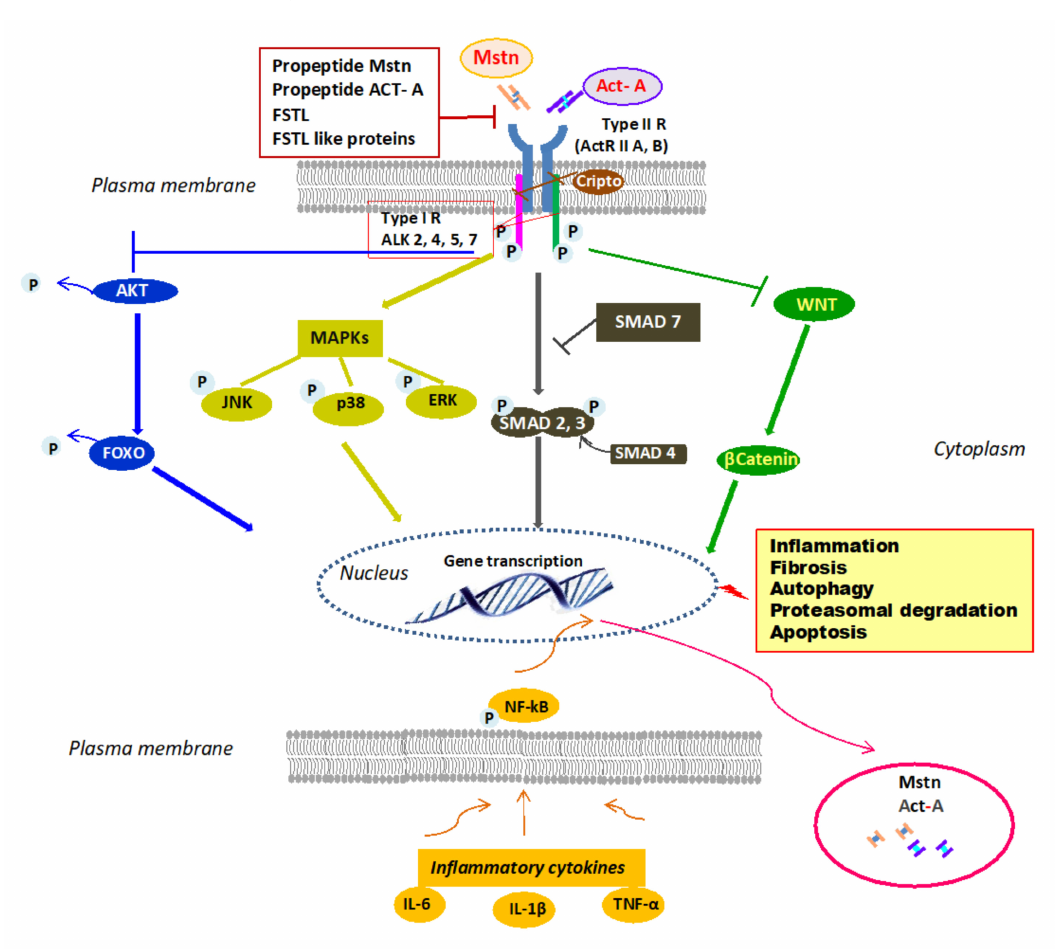
Figure 1. Mstn/Act-A cell signaling. Mstn/Act-A bind to ActRIIB/A on the plasma membrane, which leads to activation by phosphorylation of type-1 ALK 2, 4, 5, or 7. This in turn induces phosphorylation of SMAD2 and SMAD3 and the involvement of SMAD4 into a SMAD complex that translocates into the nucleus and elicits transcription of gene targets. SMAD7 inhibits SMAD pathway. Mstn and Act-A block AKT phosphorylation and consequently, dephosphorylated FOXO can enter the nucleus and promote the transcription and expression of atrophy specific genes. Mstn and Act-A can also signal through MAPK activation and WNT inhibition. The binding to the receptor is controlled by Mstn–Act-A propeptides and by circulating antagonists. Lastly, the ActRII/ActRIB receptor complex is inhibited by Cripto, a small GPI-anchored signaling protein. Inflammatory milieu contributes to Mstn and Act-A expression through NF-kB. Abbreviations: Act-A = activin A, ActRIIB/A = activin receptor